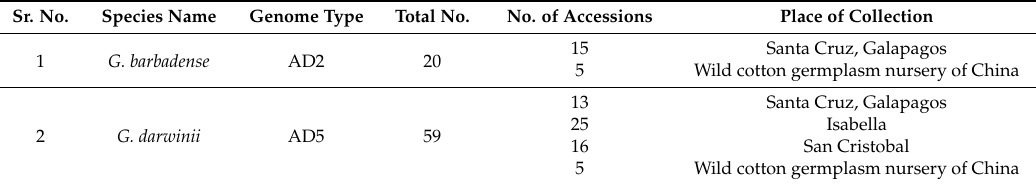
Table 1. Summary of germplasm collection from the Galapagos